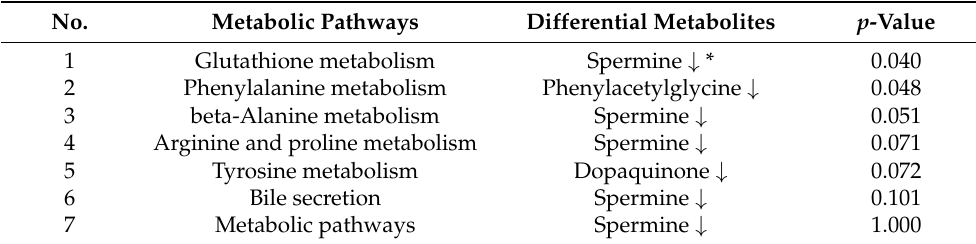
* ↑ represents upward adjustment; ↓ represents downward adjustment. AP represents the group fed alfalfa (n = 5). AOP represents the group fed a mixture of oat and alfalfa (n = 5).